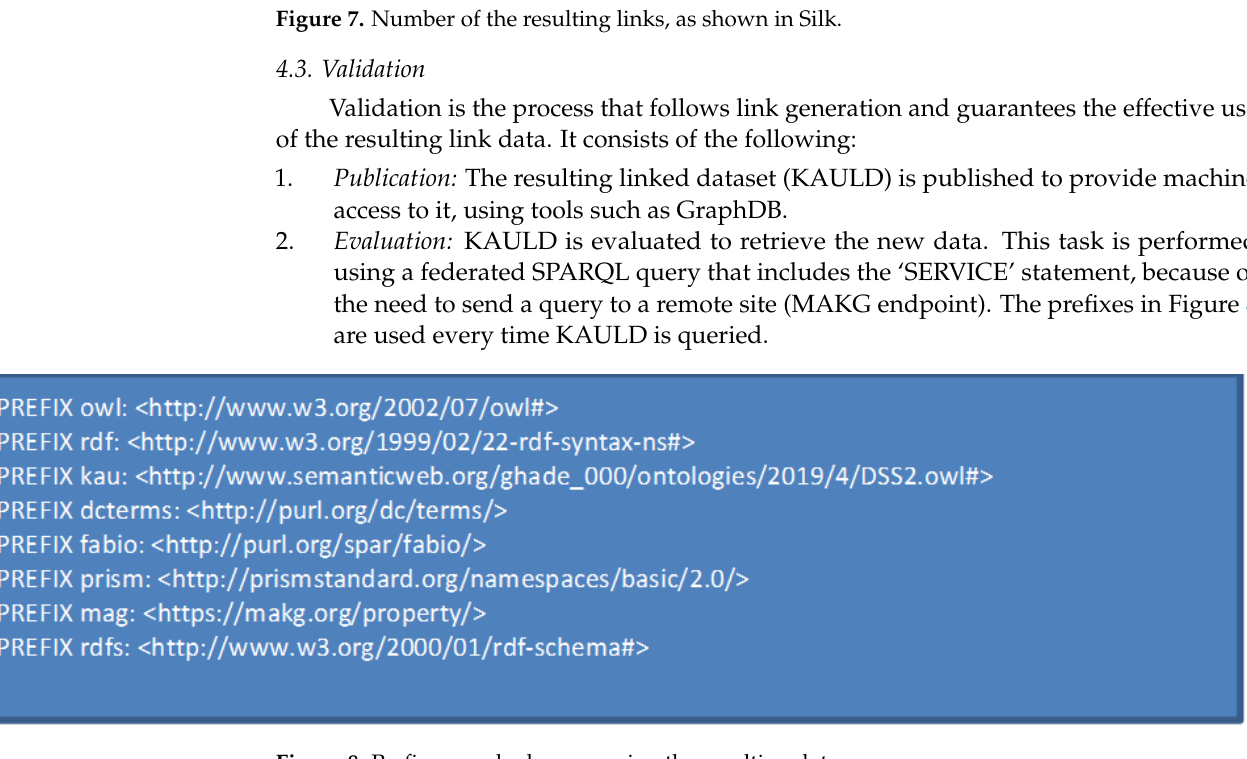
Figure 7. Number of the resulting links, as shown in Silk.